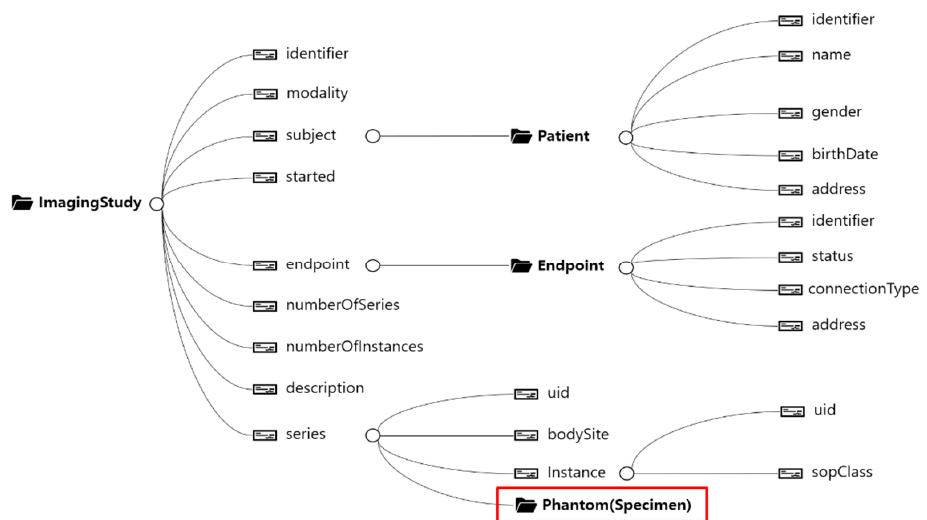
Figure 5. Addition of Phantom Resource using Specimen Resource.